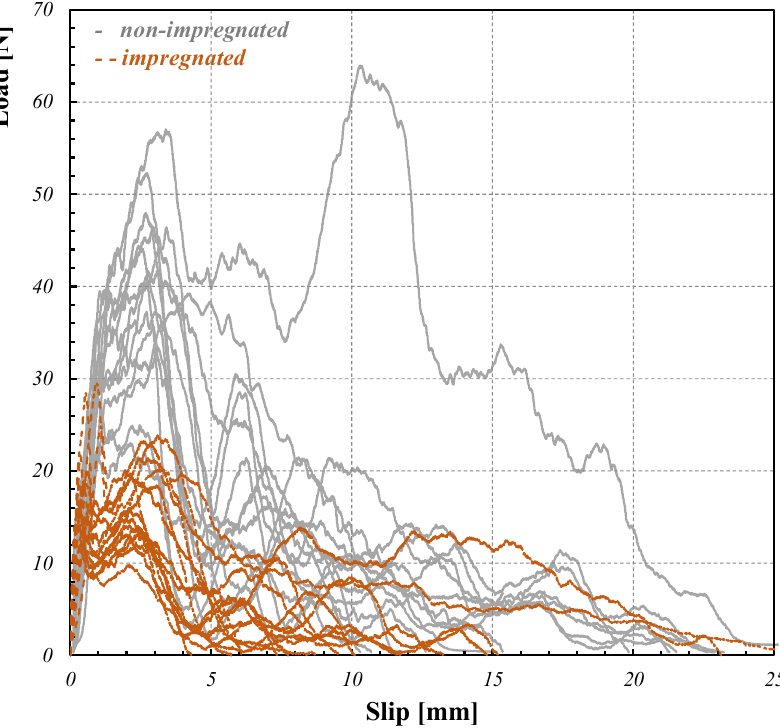
Figure 11. Pull-out test results of non-impregnated_Y_pull-out and impregnated_Y_pull-out series of specimens.